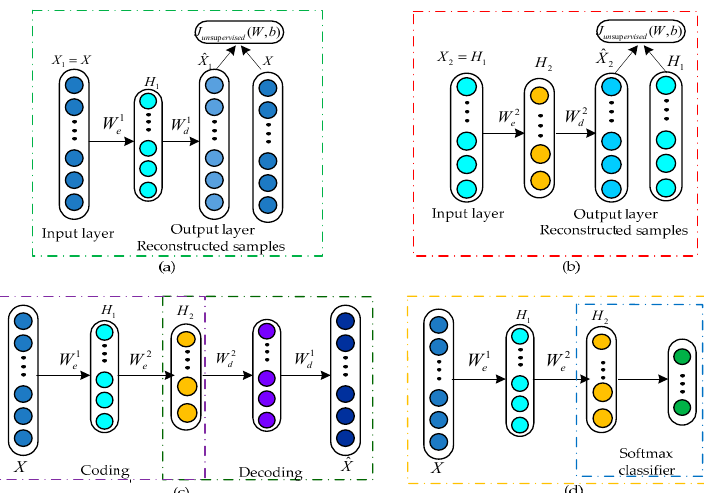
Figure 5. The construction and training of the stacked sparse denoising autoencoder (SSDAE). ( a ) the shallow sparse autoencoder (SAE), ( b ) the shallow denoising autoencoder (DAE), ( c ) the constructed SSDAE network, and ( d ) the proposed supervised learning SSDAE network.